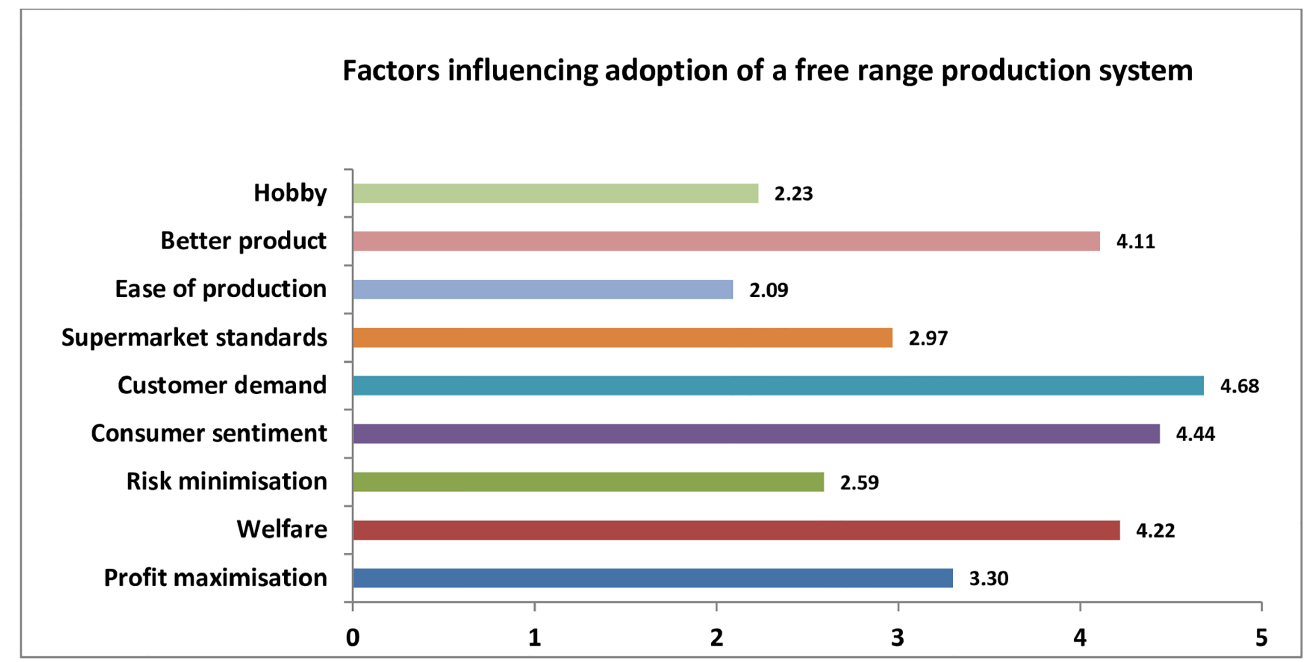
Fig 2. Factors influencing adoption of free-rangeproduction systemon respondent farms. The scale from 0–5 denotesthe weightedaverages across the five categories of agreement (Strongly disagree,Disagree,Neitheragree nor disagree,Agree and Strongly agree).